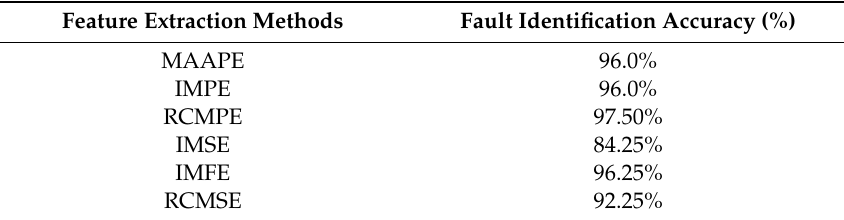
Table 3. Fault identification accuracy by combining di ff erent fault feature extraction methods with random